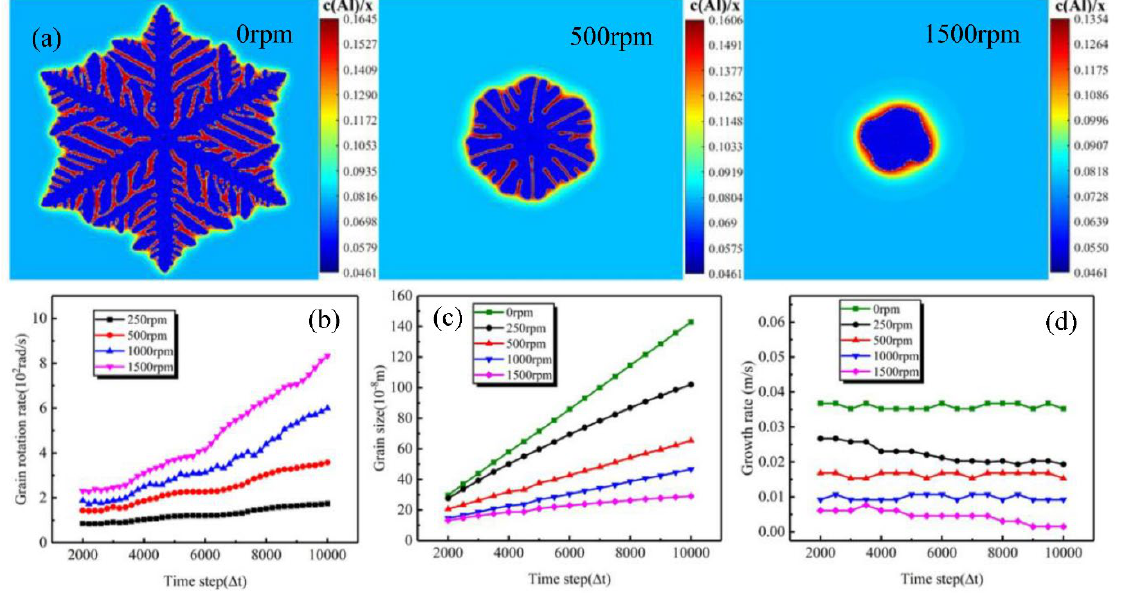
Figure 11. ( a ) the solute distribution of grain with different stirring rates. The effect of stirring rate on, ( b ) grain rotation rate, ( c ) grain size,and ( d ) grain growth rate, respectively [98].